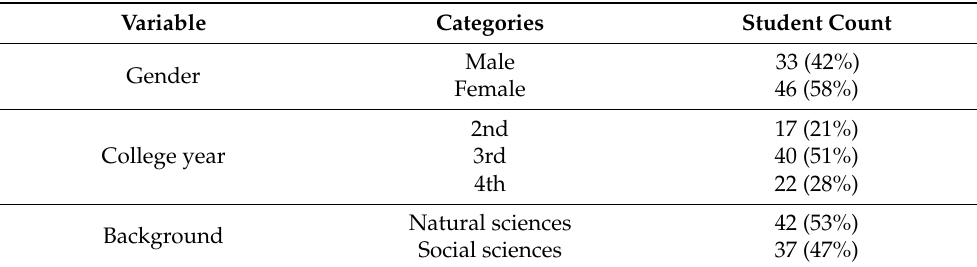
Table 1. The characteristics of samples.